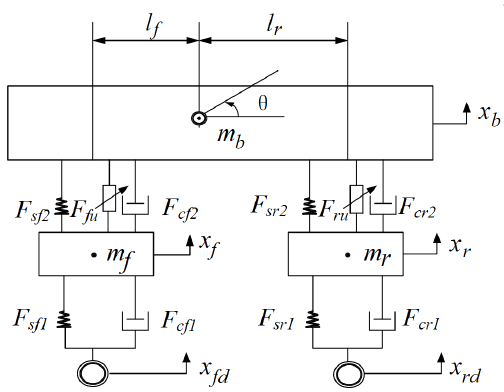
Figure 1. Nonlinear 4-DOF half-vehicle model.